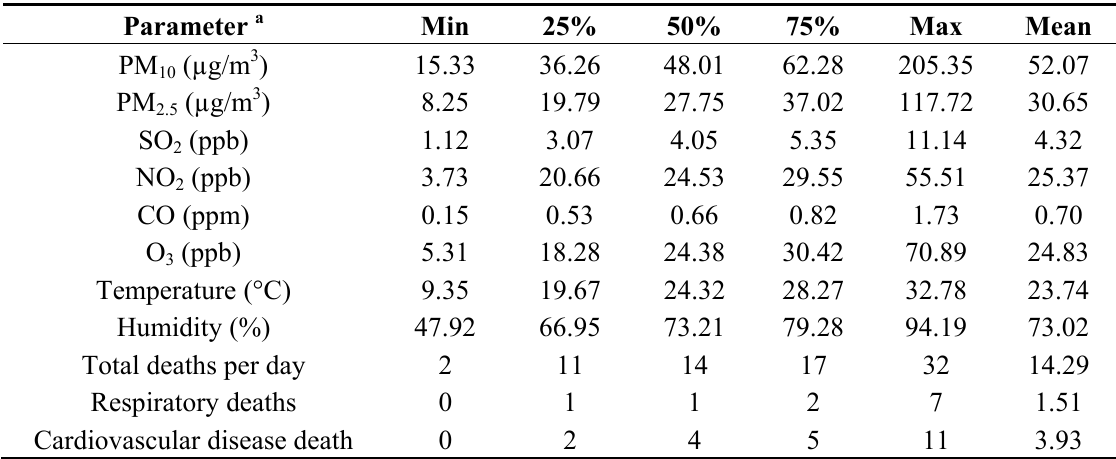
Table 2. Mortality counts, weather, and air pollutant concentrations in Taipei, Taiwan, 2006–2008.